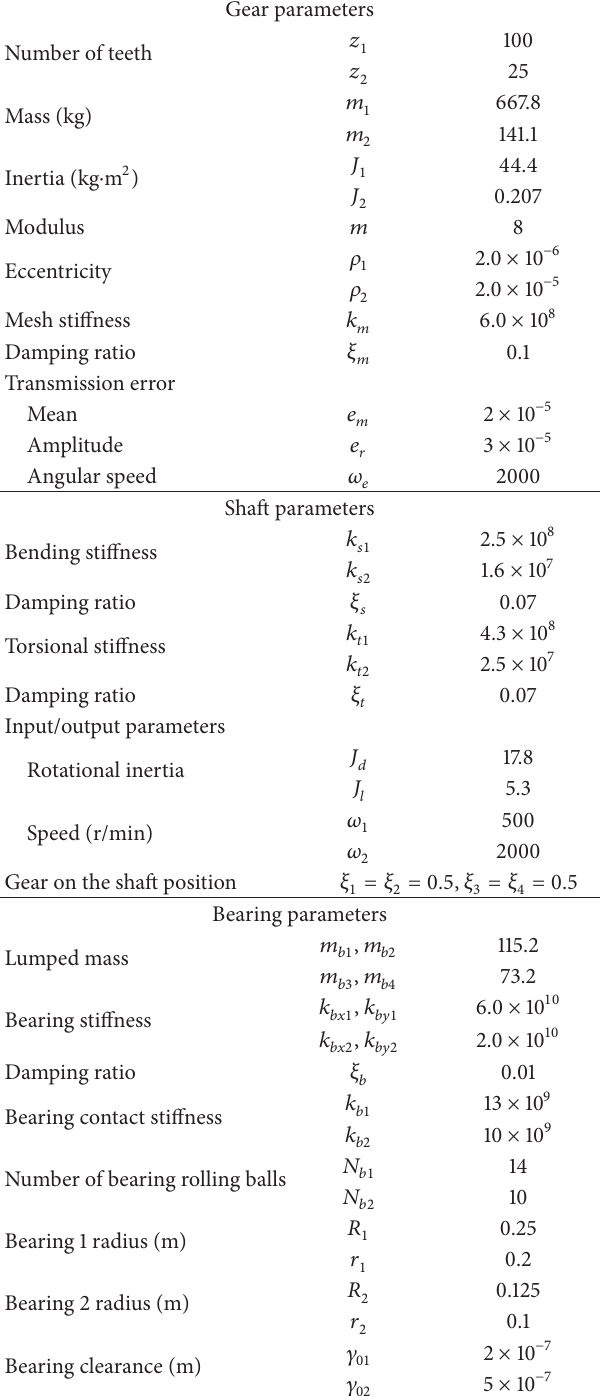
Table 1: Structure and dynamics parameters of spur gear rotor bearing